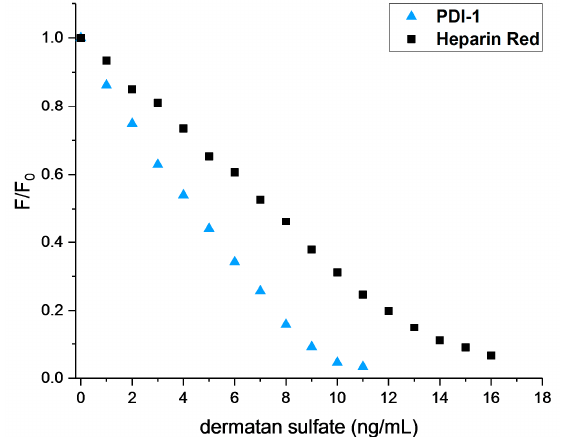
Figure 2. Normalized fluorescence response (F/F 0 ) of PDI-1 and Heparin Red to dermatan sulfate. Excitation at 570 nm, fluorescence emission recorded at 610 nm. 2.5 mL water and 0.5 mL probe solution (6 nM in DMSO/30 mM HCl) were mixed in a polystyrene cuvette and the mixture was “titrated” with 5 µL aliquots of a 500 ng/mL dermatan sulfate solution. The indicated dermatan sulfate concentration does not correspond to the actual concentration in the reaction mixture (3 mL) but is related to the 2.5 mL aqueous portion.